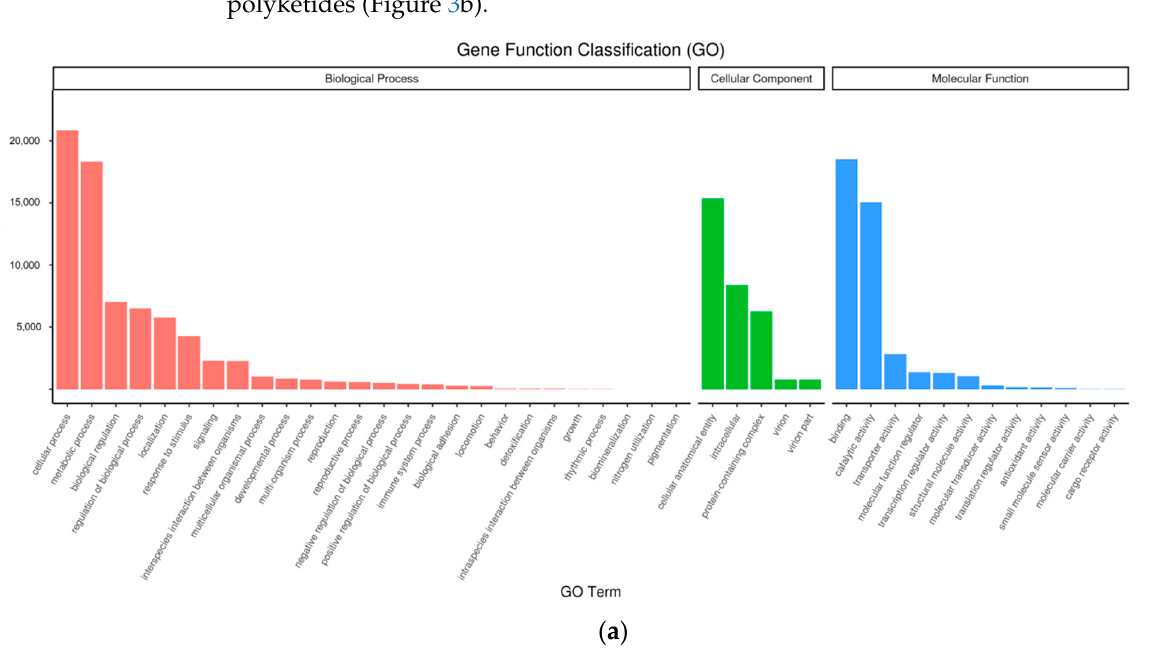
( b ) Figure 3. Gene Functional Annotation and Classification. ( a ) GO (Gene Ontology) classification; ( b ) KEGG (Kyoto Encyclopedia of Genes and Genomes) classification. 2.3. Transcription Factor Analysis Transcription factors (TFs) are well known to play a crucial role in secondary me- tabolite biosynthesis in plants [19]. We searched for genes encoding TFs and obtained a total of 2348 TFs classified into various families. The five most transcription factor anal- ysis results were GNAT, LOB, bHLH, C2H2, and MYB family (Supplementary Table S5). 2.4. Gene Expression Analysis To understand gene expression between samples, we measured transcript levels in terms of fragments per kilo-base exon per million reads (FPKM) based on RNAseq data. Genes were called Differentially Expressed Genes (DEGs) if they exhibited at least a 2-fold change in transcript abundance using edgeR ( p < 0.005). De novo transcriptome filtered by Corset was used as a reference [20].